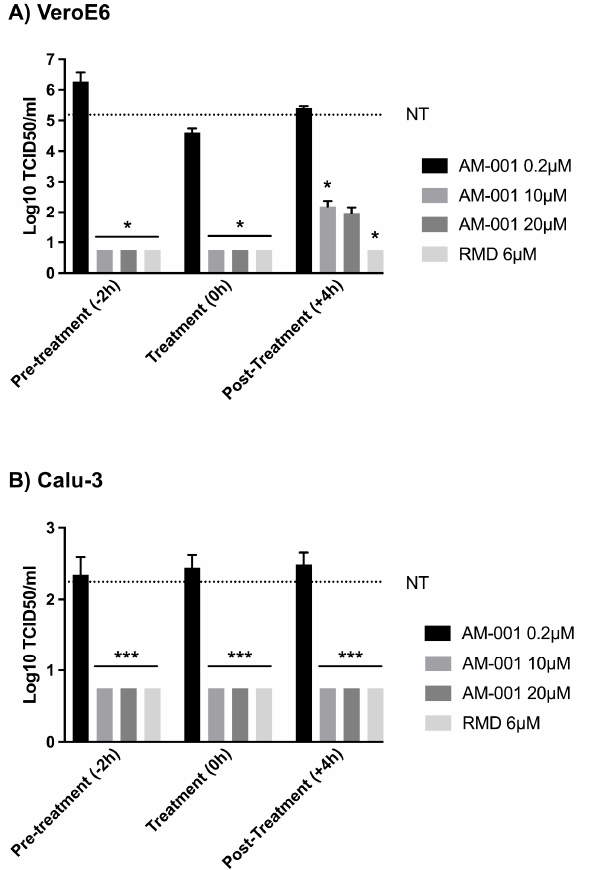
Figure 2. Evaluation of the antiviral properties of AM-001 against SARS-CoV-2 replication in VeroE6 and Calu-3 cells upon pre-treatment, treatment, or post-treatment. For the time-of-addition assay, treatments with 0.2 µM, 10 µM, or 20 µM AM-001 or 6 µM Remdesivir were initiated at -2, 0 or 4 h relative to SARS-CoV-2 infection. At 24 h post-infection, infectious particles in the supernatant of VeroE6 ( A ) and Calu-3 ( B ) cells were titrated using the TCID50 method. Results are expressed as means ± SEM from one representative experiment performed at least three times. Statistical analysis: one-way ANOVA with Dunnett’s multiple comparisons test (* indicates p < 0.05 and *** indicates p < 0.001 compared to NT cells). The dotted gray line corresponds to the mean result from NT cells.